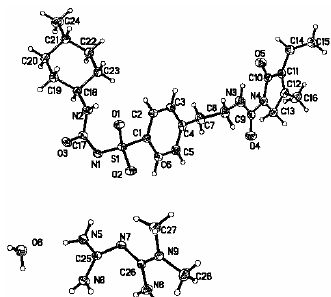
Table 1. Crystal data and structure refinement for Gli ‐ Met.